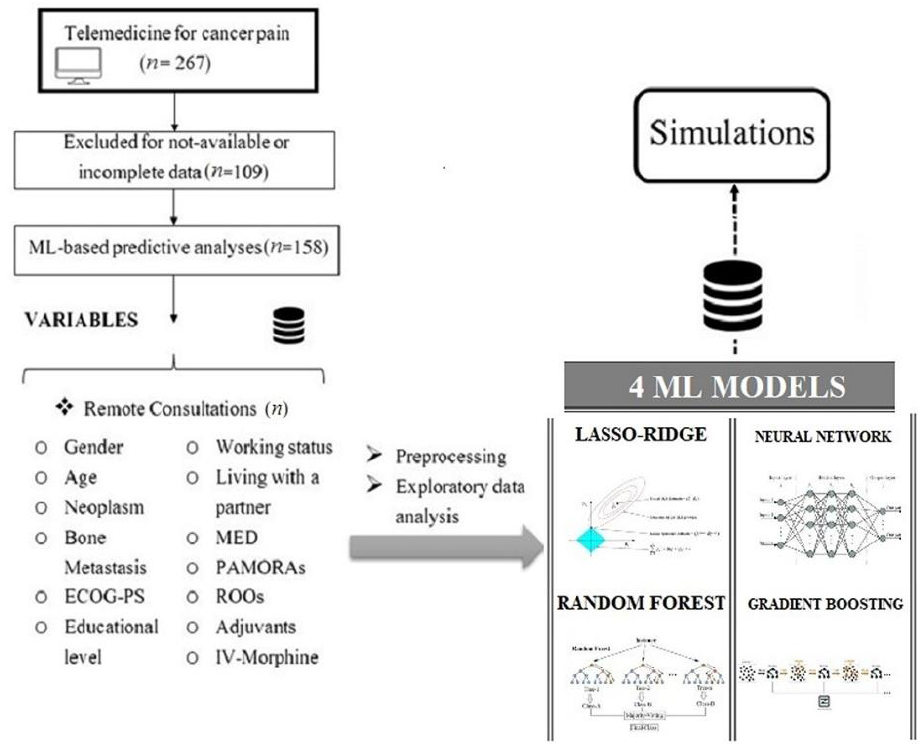
Figure 1. Flowchart of the study. Abbreviations: ML, machine learning; ECOG-PS, Eastern Coopera- tive Oncology Group Performance Status; MED, morphine-equivalent dose; PAMORAs, peripherally acting µ -opioid receptor antagonists; ROOs, rapid-onset opioids; IV-Morphine, intravenous morphine. Legend: the category “living with a partner” includes cohabitation and marriage.